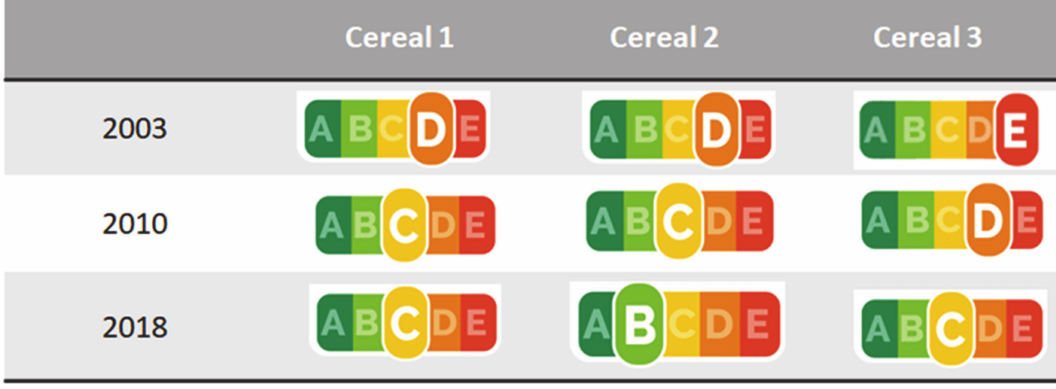
Figure 3. Changes in the Nutri-Score rating of the products studied over the 2003–2018 period. A represents higher nutritional quality, and E lower nutritional